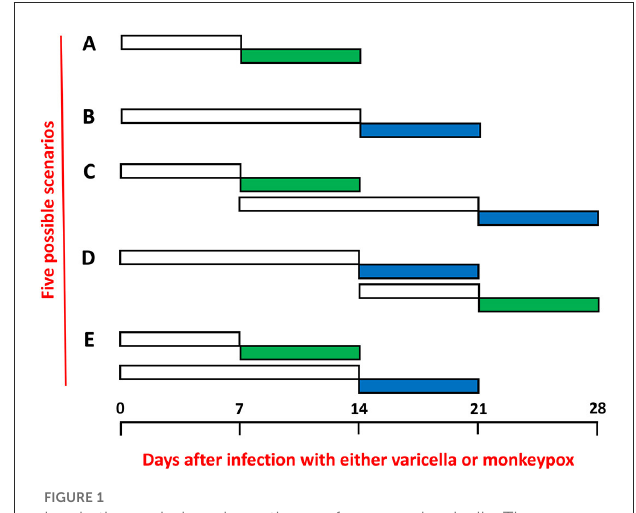
FIGURE1 Incubation periods and exanthems of mpox and varicella. The incubation periods are shown in non-colored rectangles and the periods of the exanthems are shown in colored rectangles: mpox (green) and varicella (blue). The time periods are expressed as numbers of days separated into weeks. (A) Mpox only. (B) Varicella (chickenpox) only. (C) Sequential infections with mpox first and varicella second. (D) Sequential infections with varicella first and mpox second. (E) Simultaneous infections beginning on the same day with both mpox and